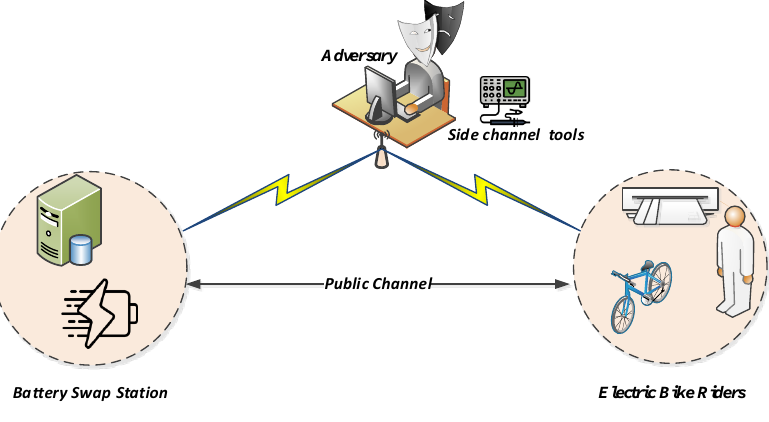
Figure 2. The used system